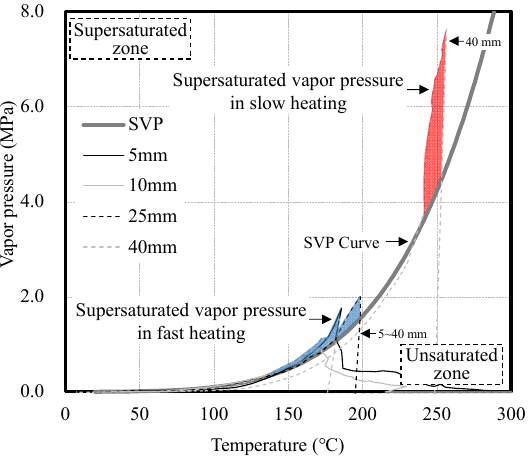
Figure 10. Vapor pressure in the 100-MPa concrete specimen that exhibited spalling.